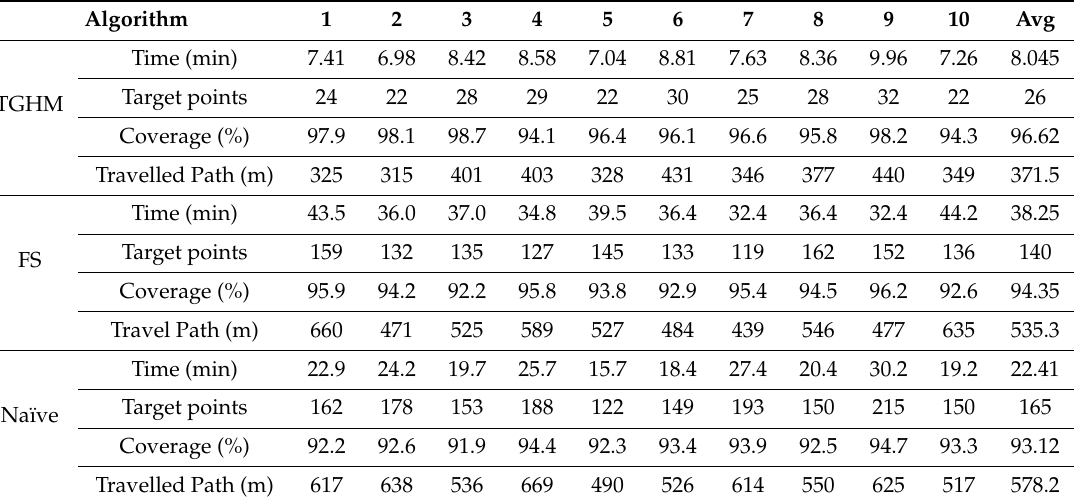
Table 1. Units for magnetic